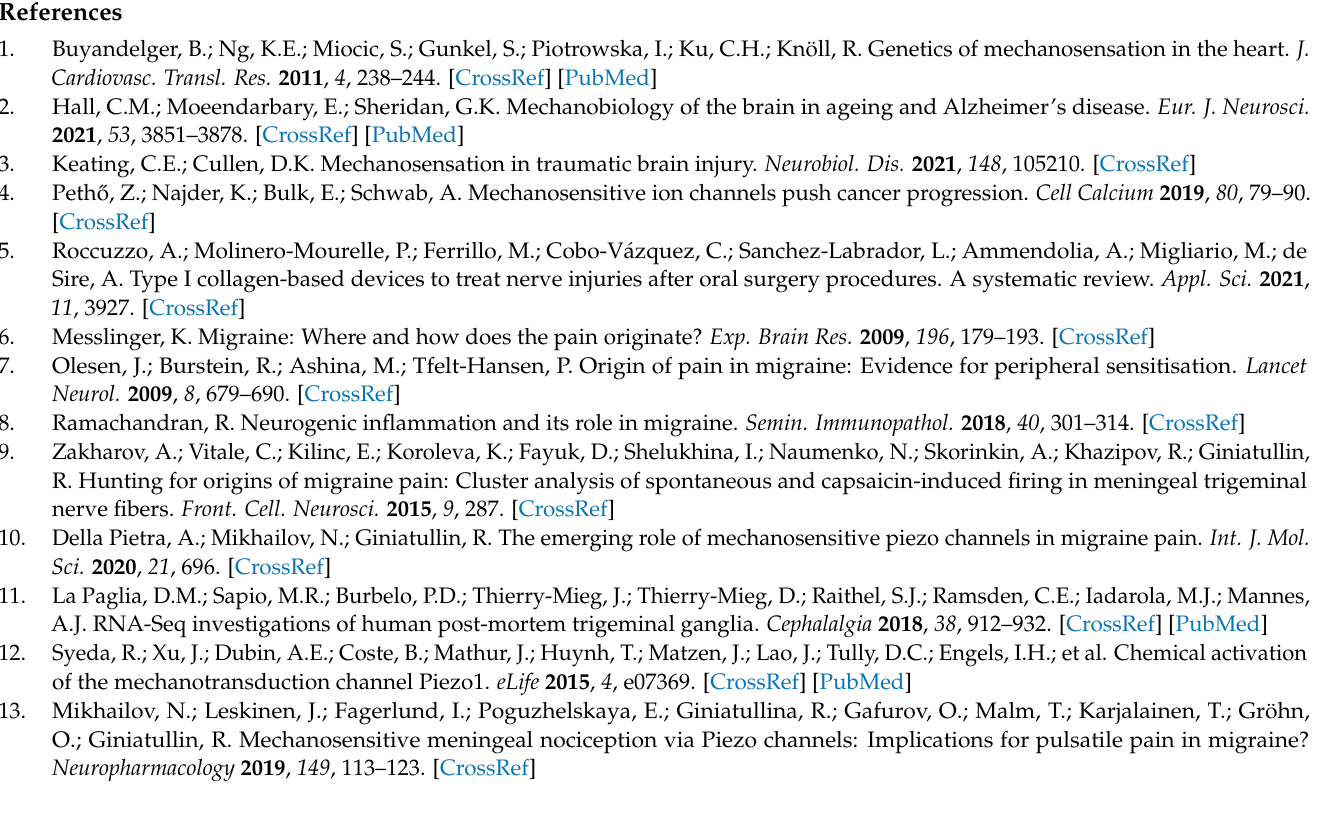
Figure A3. Dooku1 diminishes Yoda1-induced transients. ( A ) Traces depict average fluorescence of control and Dooku1 treated neurons ( n = 88 neurons for control and 29 for Dooku1-treated group, presented as mean ± SEM). ( B ) Neurons treated with Dooku1 demonstrated significantly lower responses at the end of the 30 s Yoda1 application (* p < 0.05 by Mann–Whitney U test, data presented as median with interquartile range).